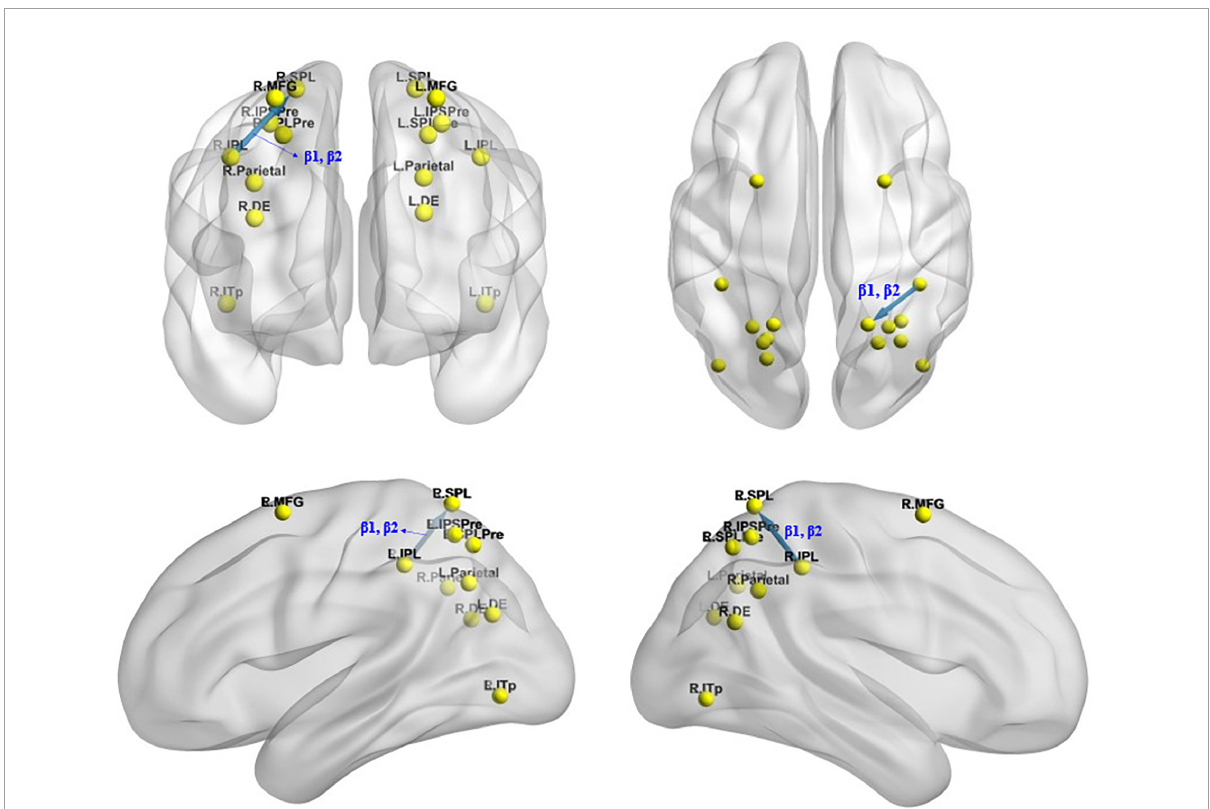
FIGURE7 Changes in effective connectivity under the mirror condition after total sleep deprivation. The effective connectivity from the R.IPL to the R.SPL was significantly reduced compared with before sleep deprivation. Blue indicates that the strength of effective connectivity is smaller after total sleep deprivation than before; Red indicates that the strength of the effective connectivity is greater after total sleep deprivation than before. The arrow indicates the direction of the connectivity; From top to bottom and from left to right: coronal view (frontal side) , axial view (dorsal side) , sagittal view (left side) , sagittal view (right side)